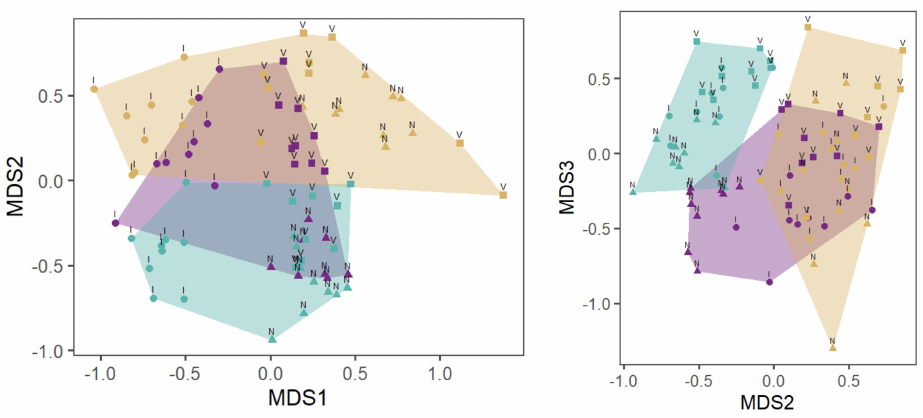
Figure 5. Nonmetric multidimensional scaling (NMDS) of MI samples from WS with I = Ihle, N = Nieplitz and V = Verlorenwasser as well as D = detritus, H = wood and S = sand. stress = 0.16 ( © Katja